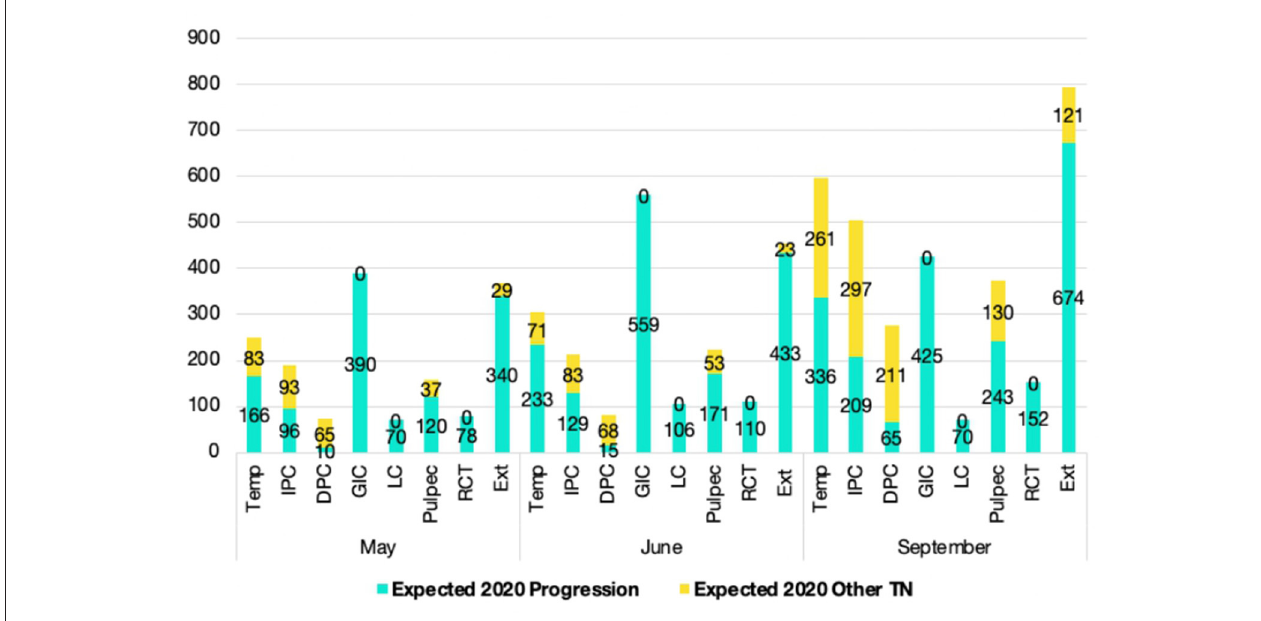
FIGURE 3 | Prediction of shift in progression of treatment needs. The prediction of progress of dental caries as shift in treatment needs are noted to have increased with every stage of the